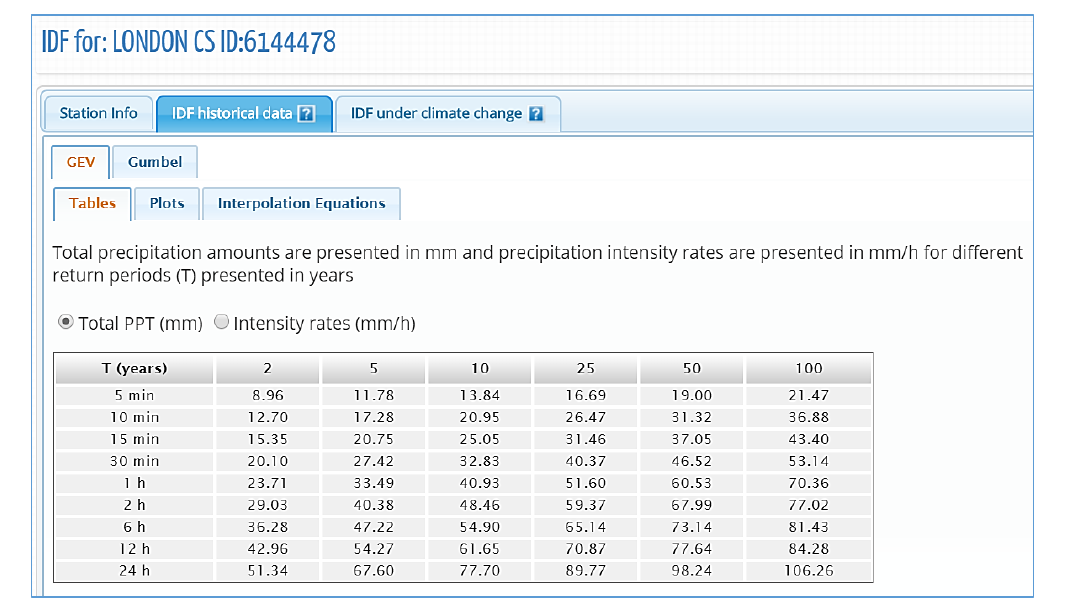
Figure 8. IDF curves for a gauged station—London CS 6144478—total precipitation